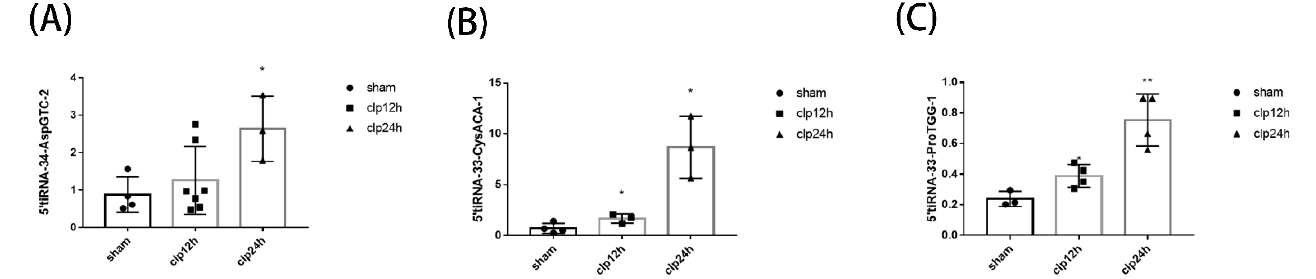
Figure 3. Identification of septic cardiomyopathy-related tsRNAs and qPCR verification. ( A – H ) The qPCR results confirmed that 5 ’ tiRNA-34-AspGTC-2( n = 4 in SHAM group, n = 7 in CLP12h group, n = 3 in CLP 24h group) 、 5 ’ tiRNA-33-CysACA-1( n = 4 in SHAM group, n = 3 in CLP12h group, n = 3 in CLP 24h group) 、 5 ’ tiRNA-33-ProTGG-1( n = 3 in SHAM group, n = 4 in CLP12h group, n = 4 in CLP 24h group) 、 5 ’ tiRNA-32-LysCTT-11( n = 4 in SHAM group, n = 6 in CLP12h group, n = 4 in CLP 24h group) 、 5 ’ tiRNA-33-AlaTGC-7( n = 4 in SHAM group, n = 7 in CLP12h group, n = 4 in CLP 24h group) 、 5 ’ tiRNA-36-ArgTCT-1( n = 4 in SHAM group, n = 4 in CLP12h group, n = 4 in CLP 24h group) 、 5 ’ tiRNA-35-LeuCAG-4( n = 3 in SHAM group, n = 5 in CLP12h group, n = 4 in CLP 24h group) and tRF5-18-ArgCCT-3( n = 4 in SHAM group, n = 5 in CLP12h group, n = 5 in CLP 24h group) were consistent with tsRNA microarray data. Data were presented as mean ± standard deviation. * p < 0.05; ** p < 0.01; *** p < 0.001 compared with the SHAM group. CLP ： Cecal ligation and puncture; qPCR: Quantitative real-time PCR; tRF: tRNA fragments; tiRNA: tRNA halves; tsRNA: tRNA-de- rived small RNA. 3.4. Targets of Septic Cardiomyopathy-Related tsRNAs As mentioned above, tsRNA has a similar function to microRNA. So we chose to use Targetscan and miRanda for target gene prediction of the following five tsRNAs with sig- nificant differences in expression (5 ’ tiRNA-33-AlaTGC-7 、 5 ’ tiRNA-36-ArgTCT-1 、 5 ’ tiRNA-33-CysACA-1 、 5 ’ tiRNA-34-GlnCTG-5 and 3 ’ tiRNA-41-ProTGG-4, Figures 4A – 4E). The target genes of tsRNA also intersect, as shown in Figure 4F. The intersections of these target genes include Yipf6 and NCOA4. Yipf6 is a five transmembrane-spanning protein associated with Golgi compartments, and Yipf6 has been shown to be associated with spontaneous intestinal inflammation in mice [26]. NCOA4(nuclear receptor coacti- vator 4) mediates the selective autophagic degradation of the cytosolic iron storage